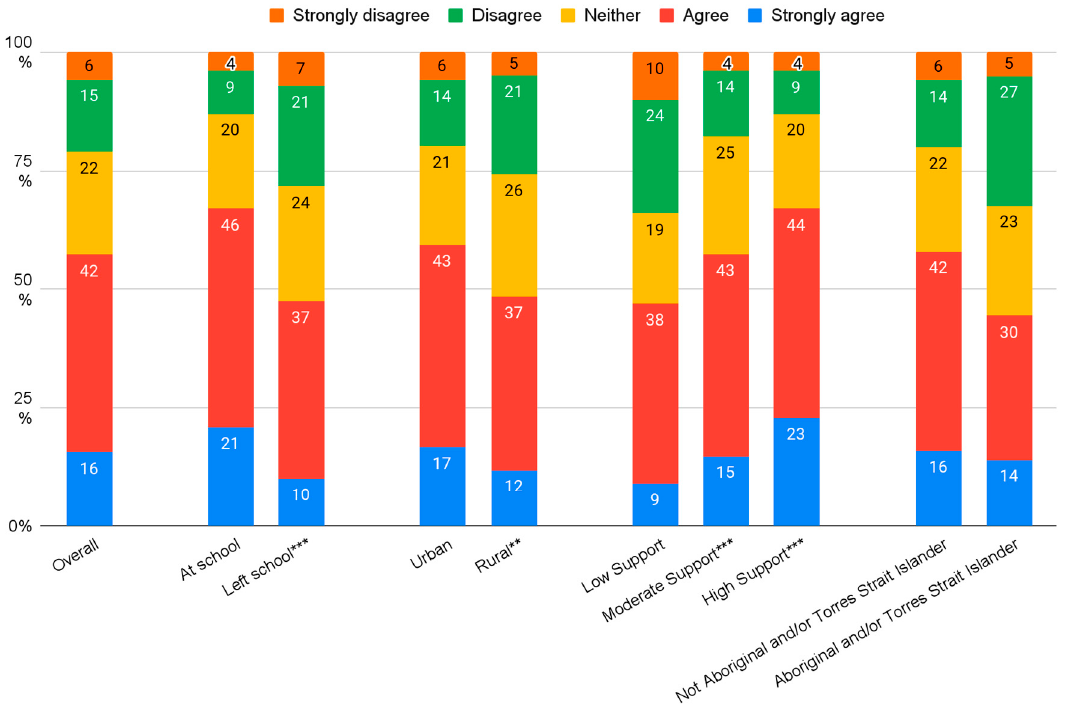
Figure 4. ‘I am likely to seek career advice in the next 12 months’ (Data source: survey; n = 1108. ** p < 0.01; *** p < 0.001).